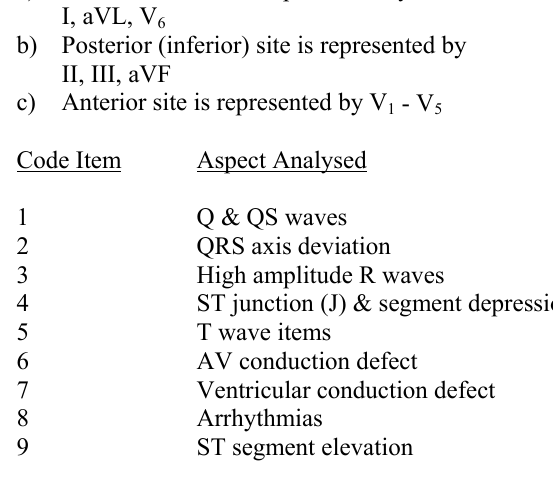
Table 8(a): Frequency of various Minnesota codes in the male population of different age groups in the two study sites.